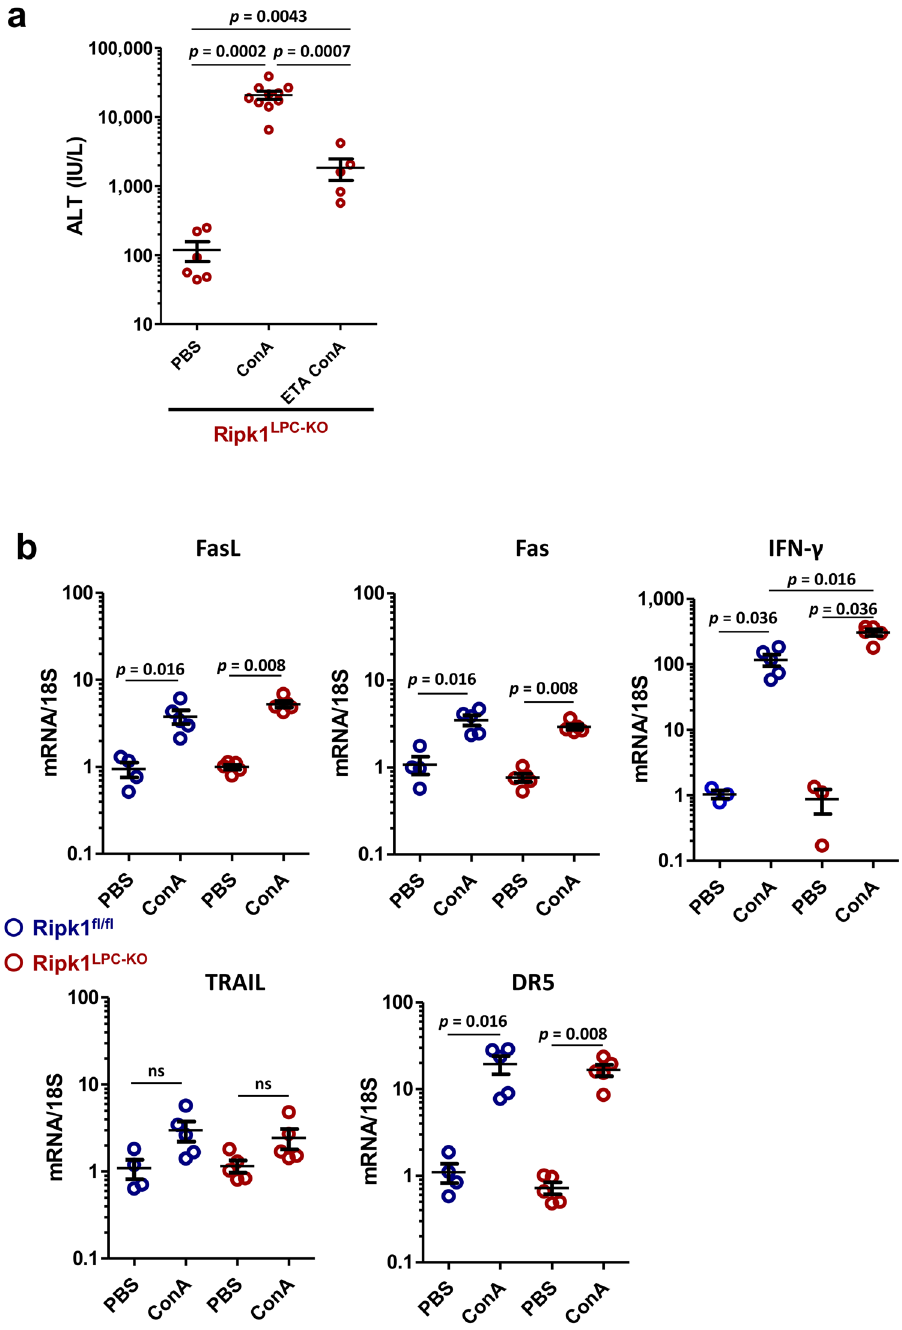
Figure 1. TNF- α inhibition partially protects Ripk1 LPC-KO mice from ConA-induced liver injuries. ( a ) Levels of serum ALT, 11 h after PBS or ConA injection in Ripk1 LPC-KO mice, potentially pre-treated with ETA. Number of mice for each group: PBS (n = 6), ConA (n = 10) and ETA + ConA (n = 5). ( b ) Levels of hepatic FasL, Fas, IFN- γ , TRAIL and DR5 transcripts in Ripk1 fl/fl or Ripk1 LPC-KO mice 7 h after treatments with PBS or ConA (n = 3–5), (ns: non-significant). For all graphs, each circle represents an